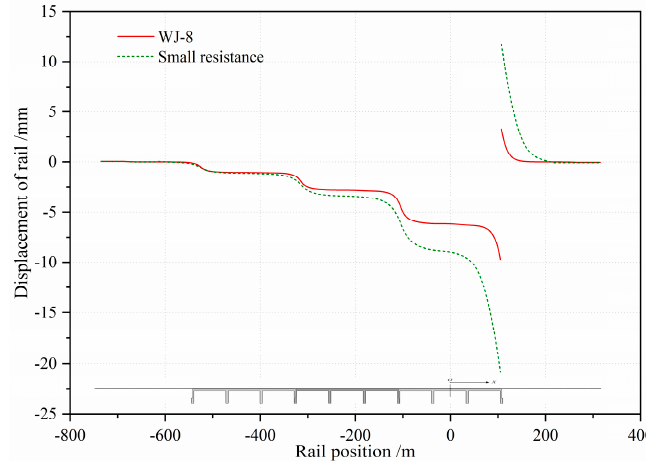
Figure 15. Displacements of the rail in the case of rail fracture.